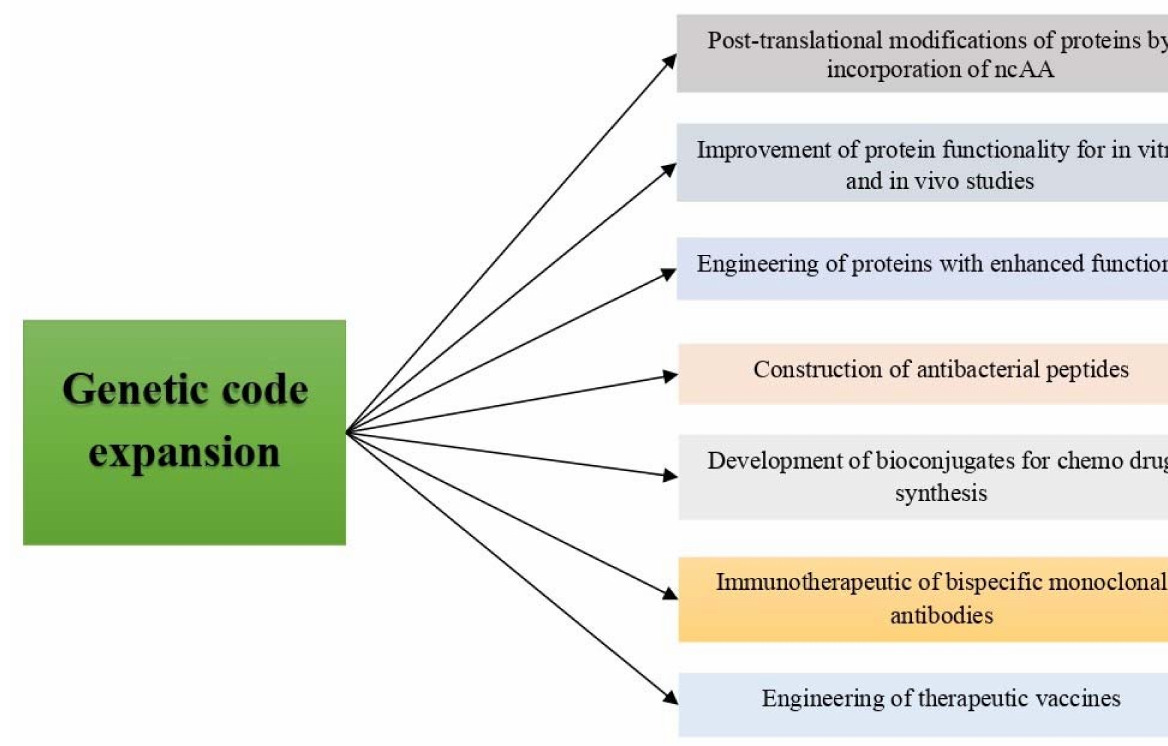
Figure 5. Applications of genetic code